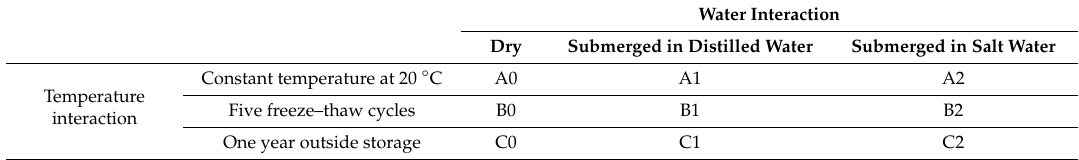
Table 5. Series description.